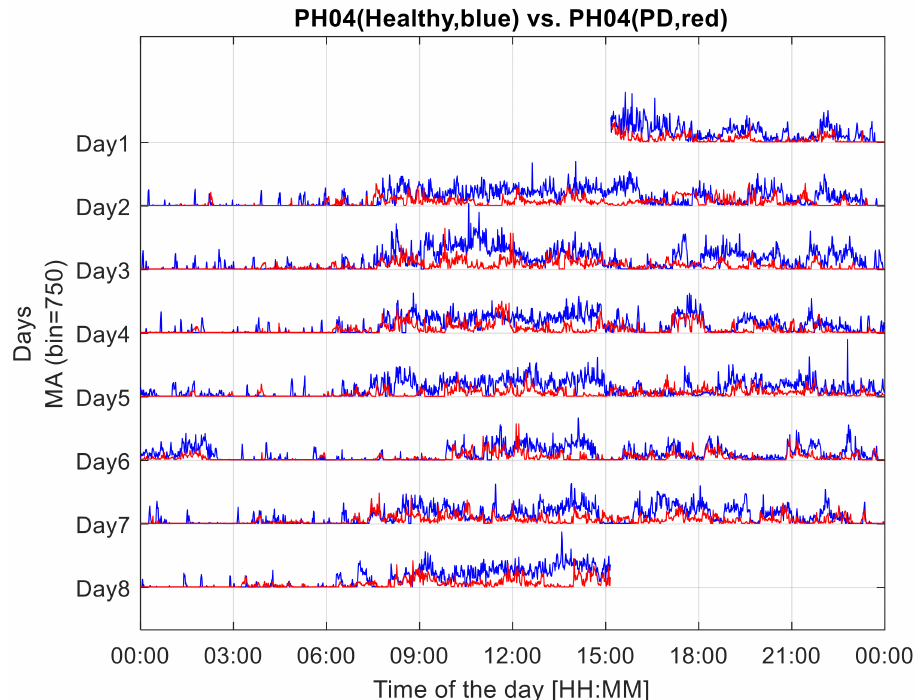
Figure 1. Seven-day profiles of MA, Motor Activity indices, computed in 1-min epochs from the recordings of the two components of a couple, the experimental dyad. The MA profile of the healthy component of the dyad is drawn in blue. That of the dyad component with Parkinson’s disease is drawn in